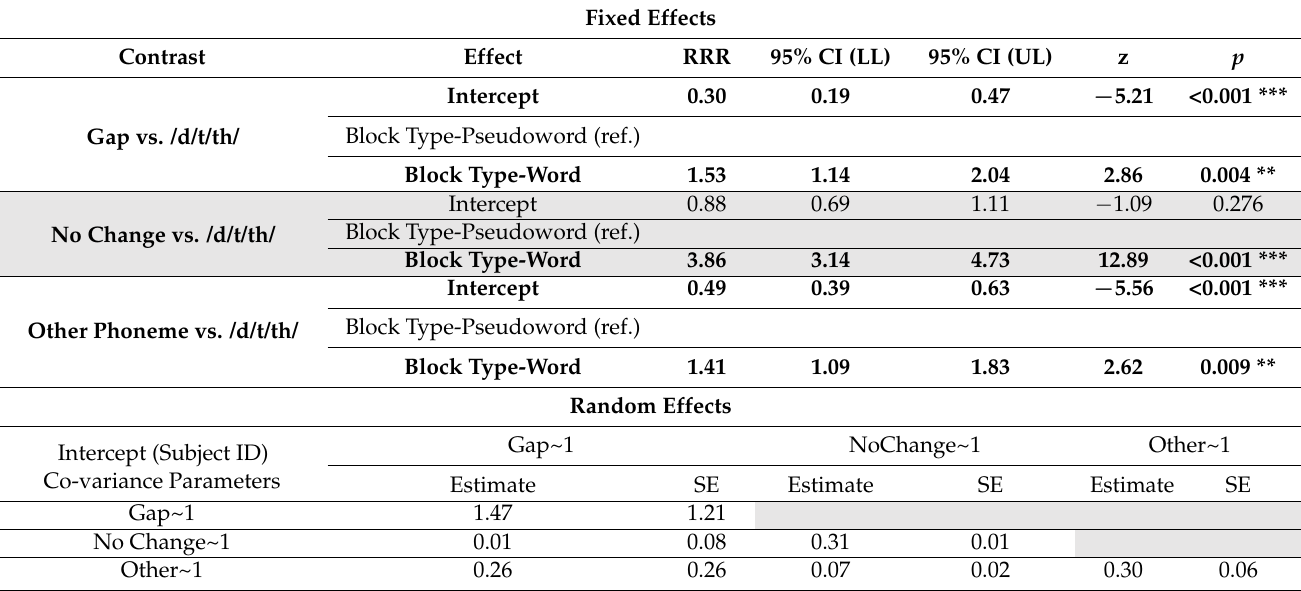
Table 1. Results of the Multinomial Logistic Regression to examine the effect of Block Type (Words vs. Pseudowords) on perception. Significant fixed effects are depicted in bold font and indicated with asterisks as follows: ** p < 0.01, *** p < 0.001. Fixed